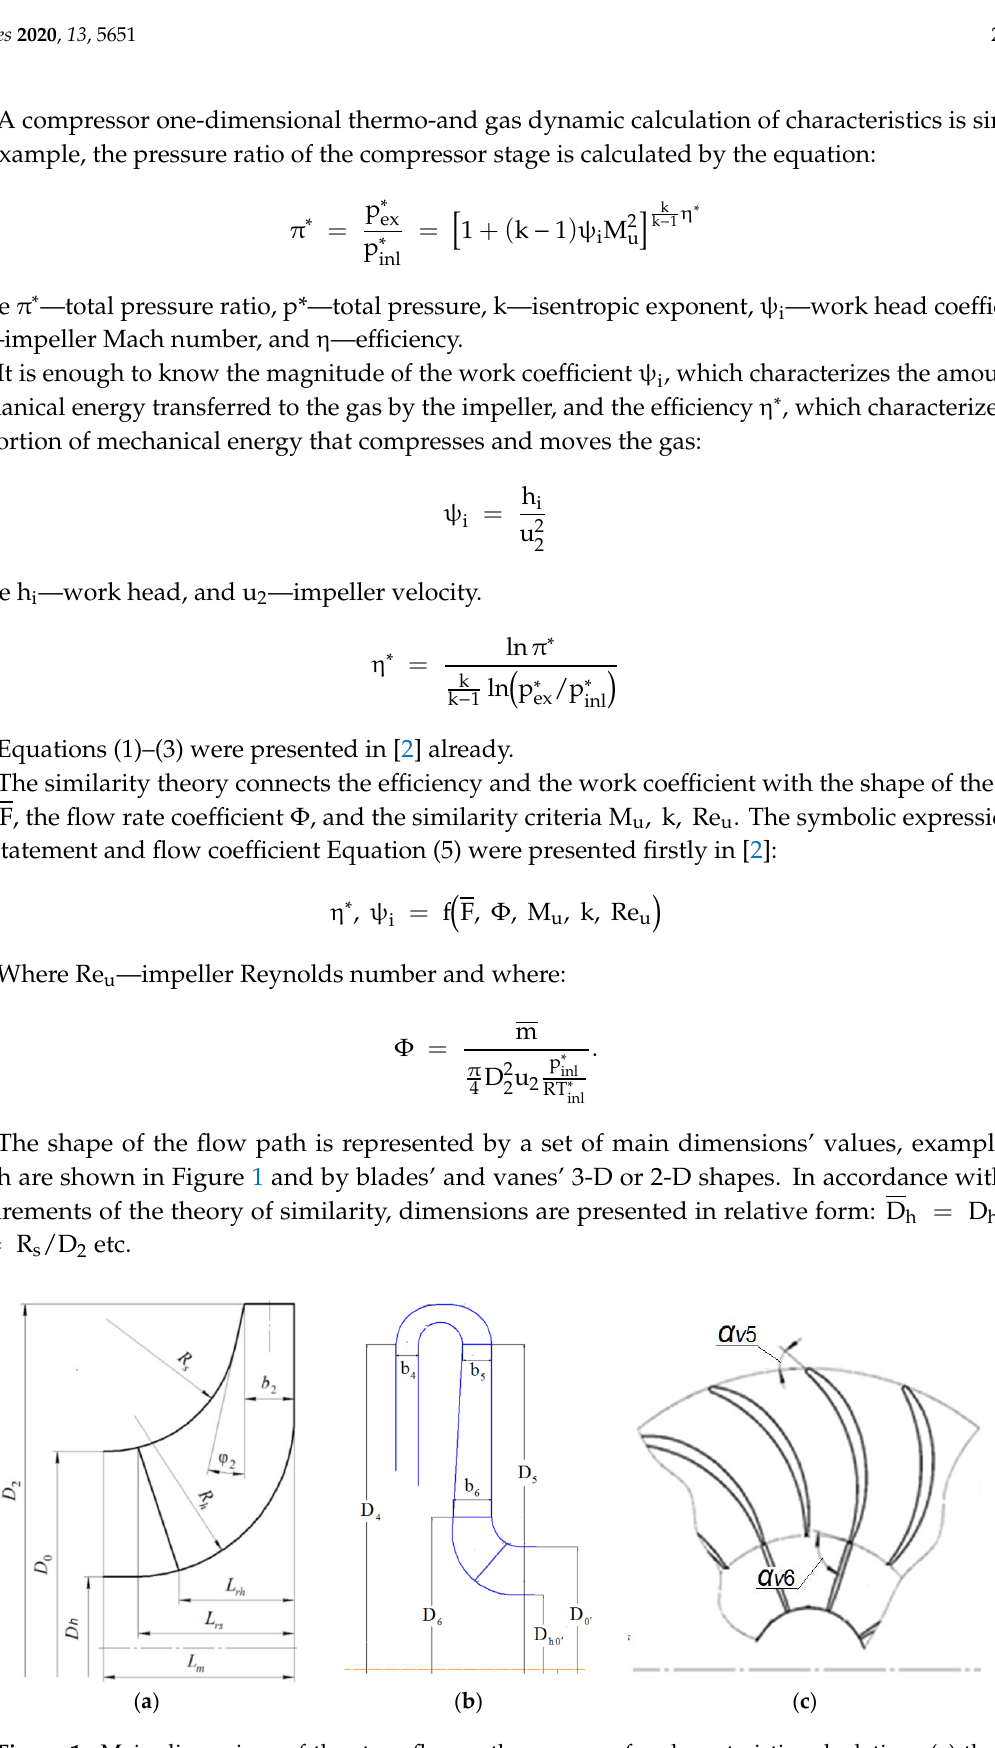
Figure 1. Main dimensions of the stage flow path necessary for characteristic calculation: ( a ) the impeller, ( b ) the vaneless diffuser and the return channel, ( c ) the vane cascade of return channel. The only correct solution of the parametric Equation (4) is a compressor test. Flow motion